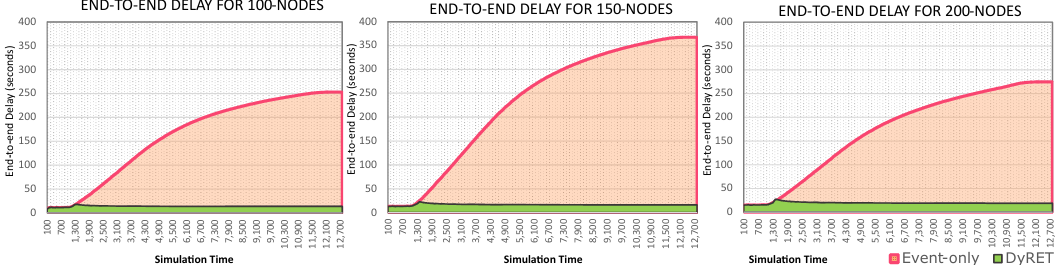
Figure 15. Timeline of delays (the range evaluated is 0 until the time the values remain